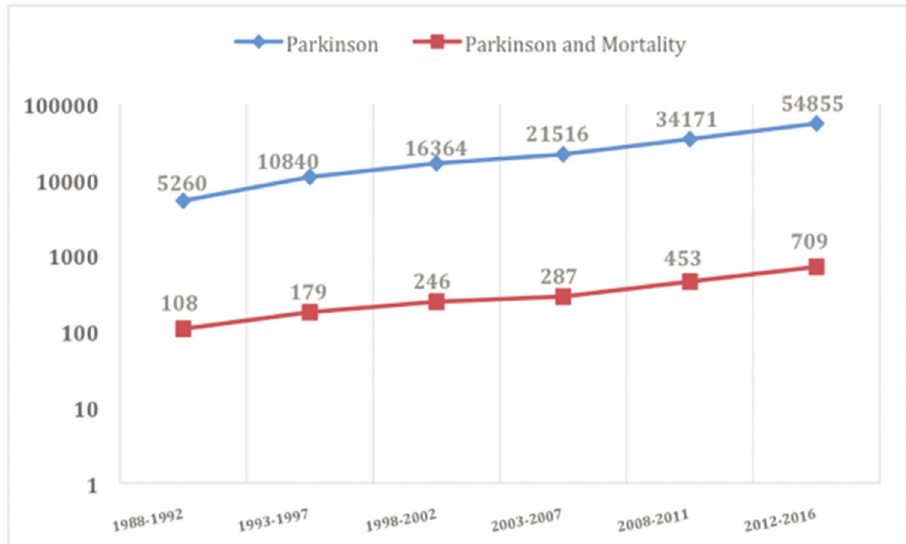
Figure 1 - Distribution of publications (log scale) on ‘‘ Parkinson ’ s ’’ and ‘‘ Parkinson ’ s and Mortality ’’ from 1988 to 2016, in intervals of five years. Publications related exclusively to PD are shown in blue (143,006 articles). Publications related to mortality in PD are shown in orange (1,982 articles). Data were identified through searches of MEDLINE, SCOPUS and